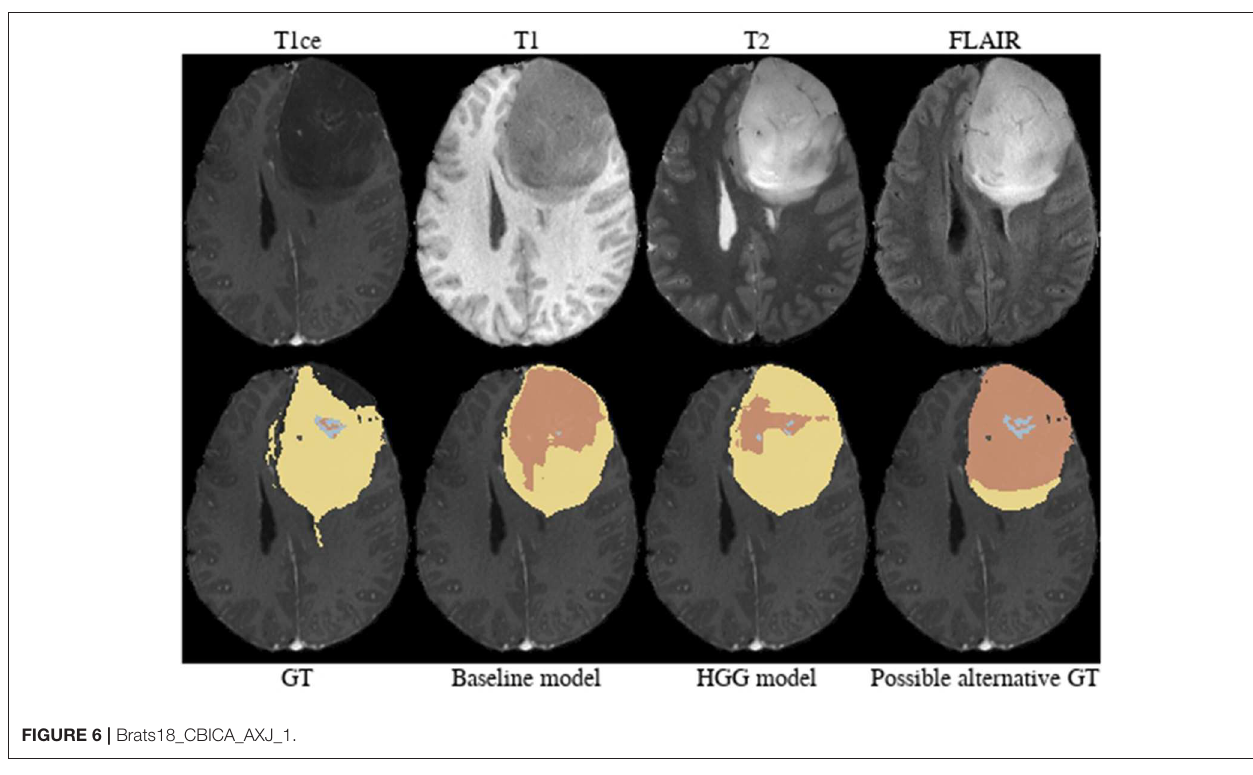
FIGURE 6 | Brats18_CBICA_AXJ_1.